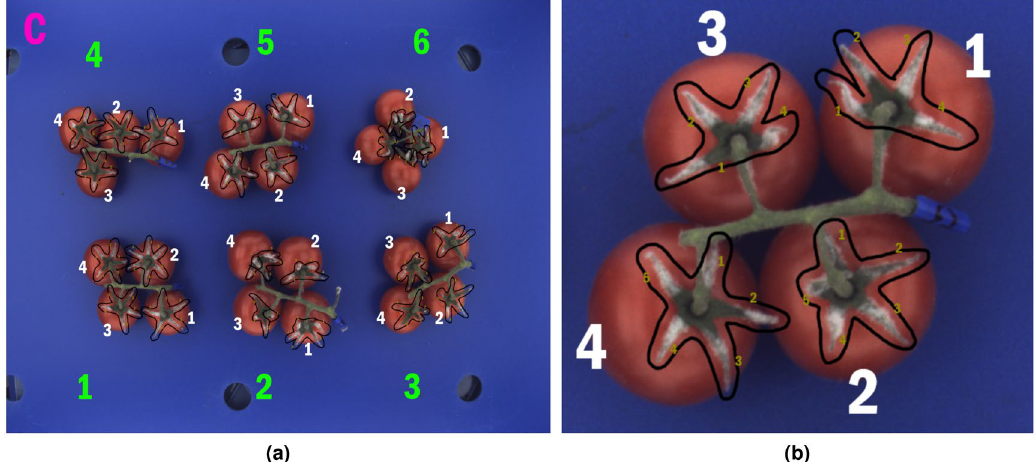
Figure 3. ( a ) Color cabinet RGB image of Batch C with marks used for enumeration. For enumeration of color cabinet image, an alphabet label was used for denoting the batch i.e. letter from A to F, while tomato trusses were enumerated from 1 to 6. Tomatoes within trusses were numbered from 1 to either 4 or 5, depending on the number of tomatoes in a truss. Sepals are denoted with numbers from 1 up to either 4 or 5, depending on the total number of sepals that are visible in the image. The sepals numbering was made according to the orientation rules presented in Fig. 1. ( b ) Cropped region in color cabinet image on the left related to the truss settings on 18-Dec-2017, and it was observed that almost all sepals had been infected to some degree (except Batch F). To objectively capture the degree of infection, a reference data set was created with the RGB images of the trusses. This was done using the Smart Color Inspector 41 , SCI, which is a controlled and closed environment with calibrated light and camera settings to record true color of objects placed inside it. SCI is designed by WFBR and built by IPSS Engineering (both based in Wageningen, The Netherlands). It is mounted with LED arrays (4038 K) on five sides and is equipped with an RGB camera (MAKO G-192C POE, Allied Vision Technologies GmbH, Stadtroda, D) that takes images from above. For each measurement series, the system is calibrated with a white background (Forex (cid:31) PVC Plate White 6 mm) and a 24-plane color chart (Color checker classic, X-rite Europe GmbH, Regensdorf, S). The color images were used as ground truth for the assessment of the degree of fungal infection. Figure 3 shows a color image of trusses for Batch C and the encoding rules which were adopted to relate the assessed